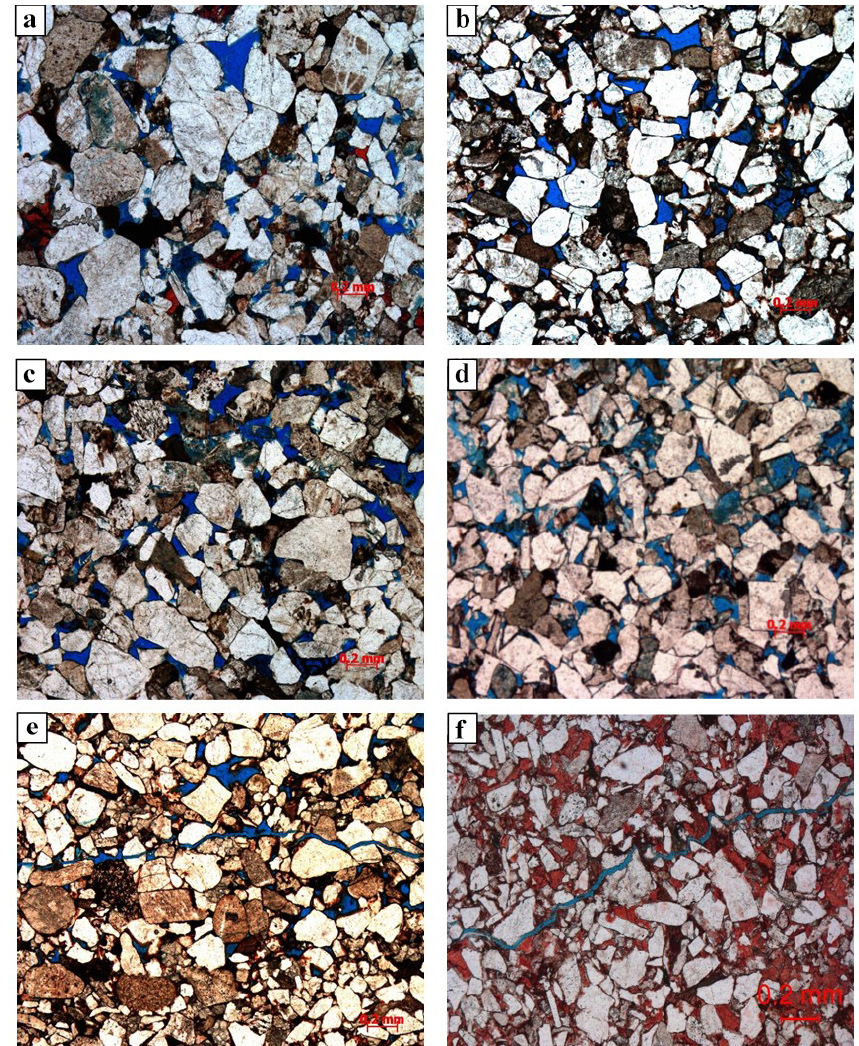
Figure 4. Thin section images showing the pore spaces of Cretaceous Bashijiqike Formation in Kuqa Depression (Xin et al., 2022). (a) In- tergranular pores, Bozi 301, 5843.8m. (b) Residual intergranular pores with irregular morphology, Bozi 9, 7689.32m. (c) Framework grain dissolved pores, Bozi 301, 5846.95m. (d) Intragranular dissolution pores, Keshen 242, 6564.1m. (e) Micro-fractures in sandstone with intergranular pore spaces, Bozi 9, 7675.95m. (f) Micro-fractures in carbonate cemented sandstone, Bozi 22,